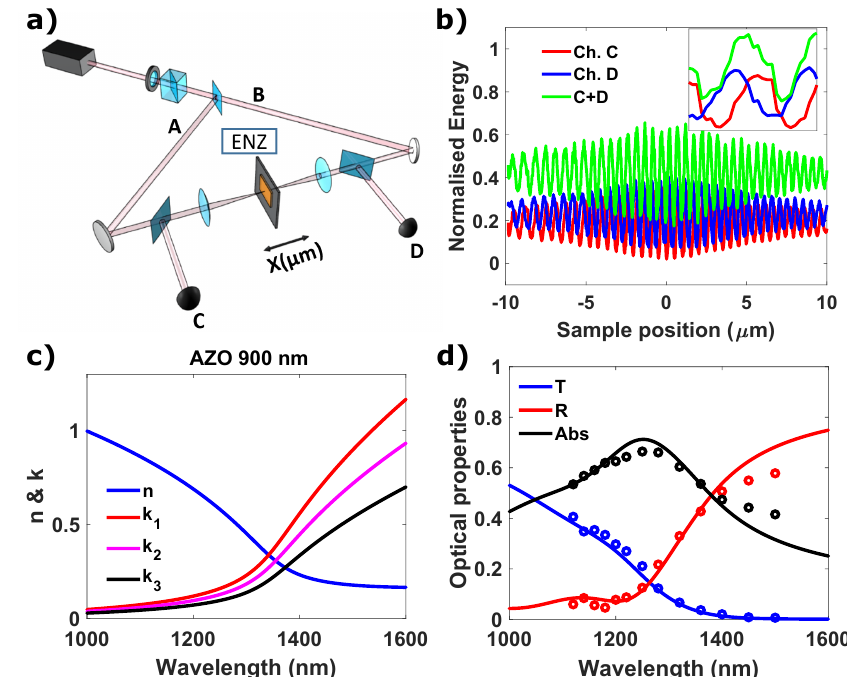
Figure 3. ( a ) Schematics of the Sagnac interferometer. ( b ) An example of measurement for λ 0 = 1280 nm, assuming energy equal to 1 at the interferometer input. The total modulation of the energy (or absorption) is given by the sum of C and D (green curve). The inset shows a zoom of the interferogram. ( c ) ellipsometer measurement of the index of refraction of AZO 900 nm thick film, ( d ) experimental (dots) and TMM simulation (solid line) of R, T and abs for the same